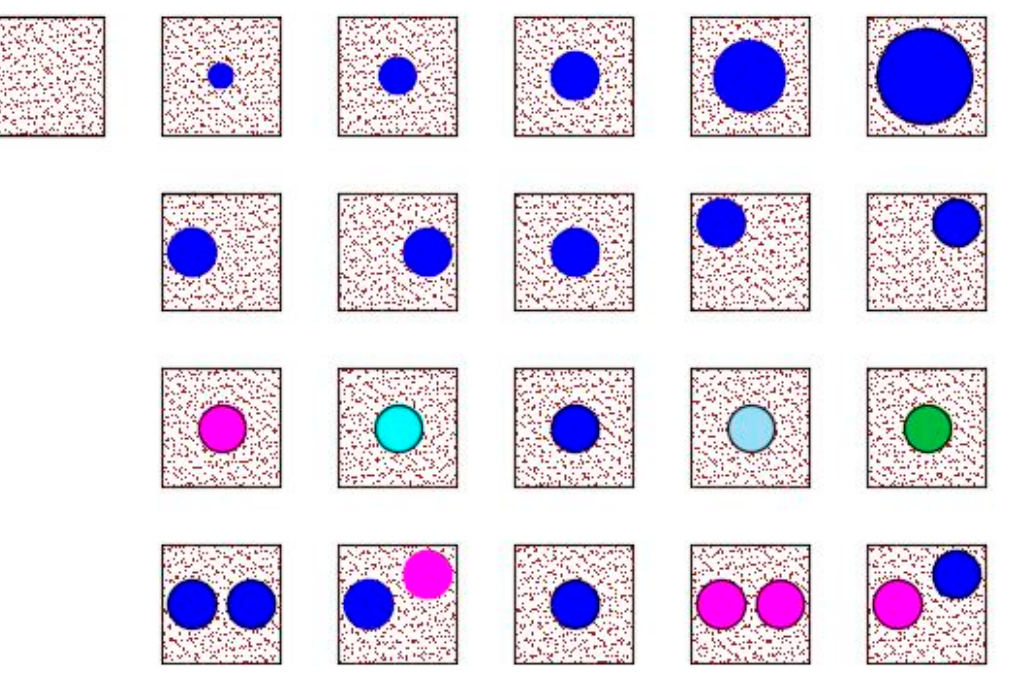
Figure 5. Test matrix.